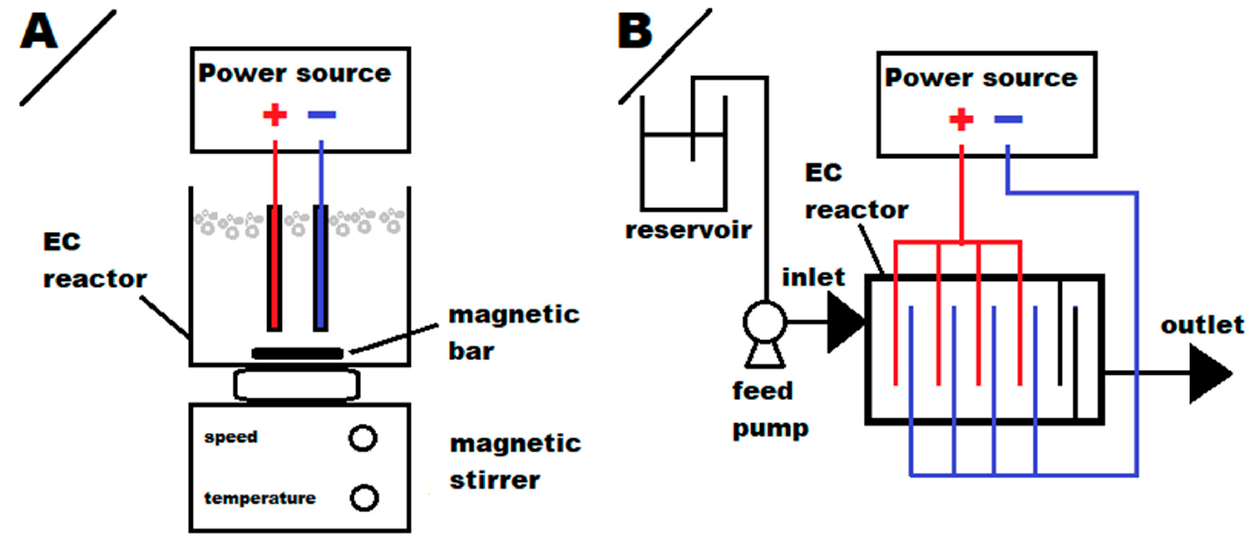
Figure 1. Reactor set-up for ( A ) batch electrocoagulation (BEC) and ( B ) continuous electrocoagulation (CEC) experi- ments.